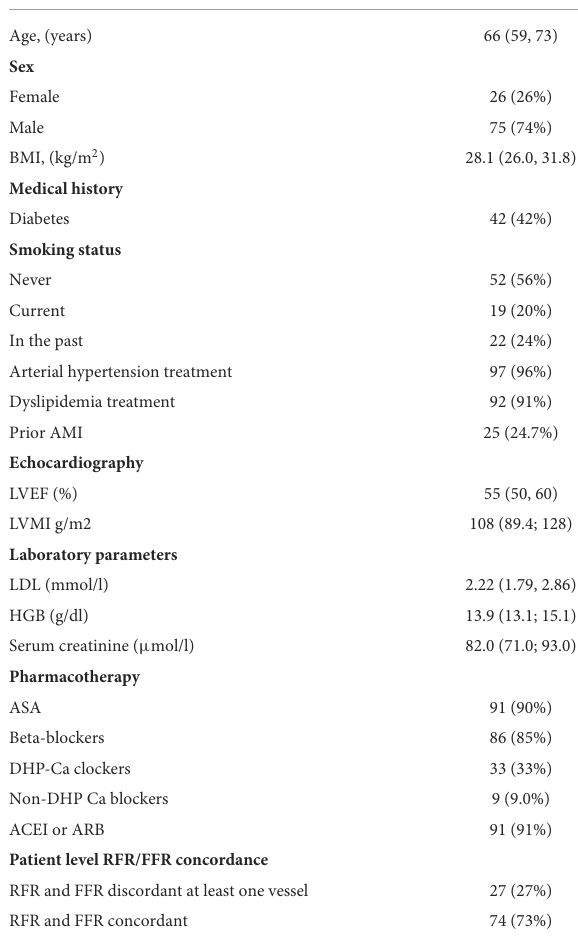
TABLE 1 Baseline clinical